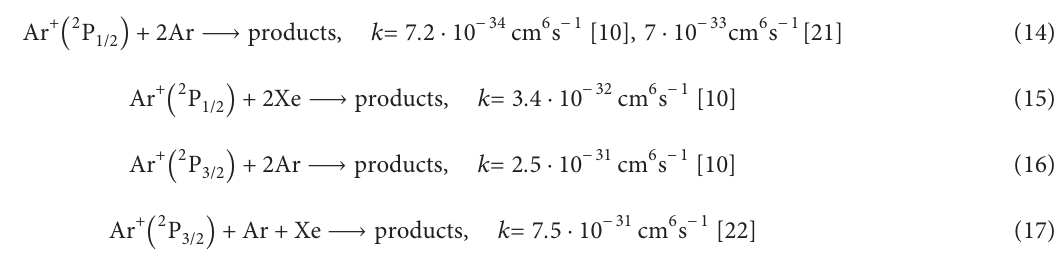
Figure 11: Dependence of the intensity of 491nm band in Kr-Xe mixture on the reverse temperature of gas